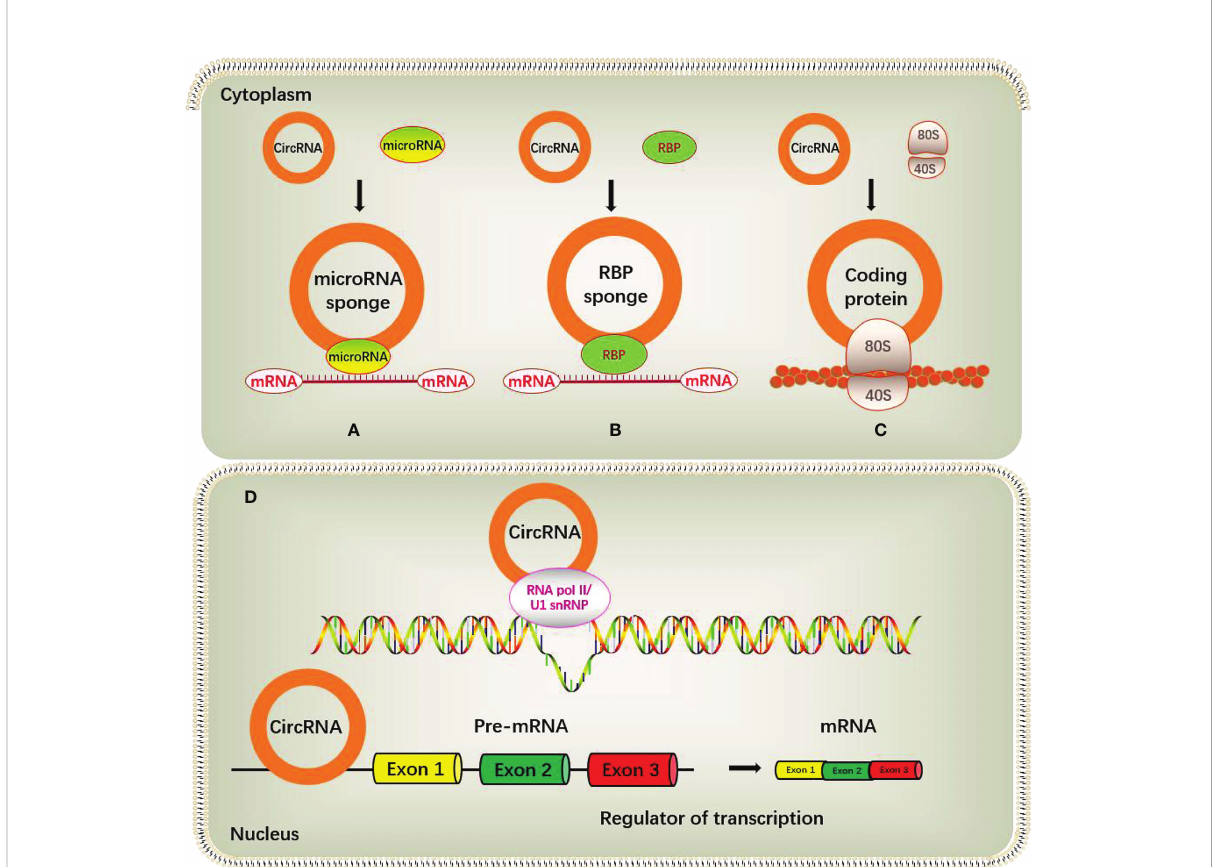
FIGURE 2 Biological functions of